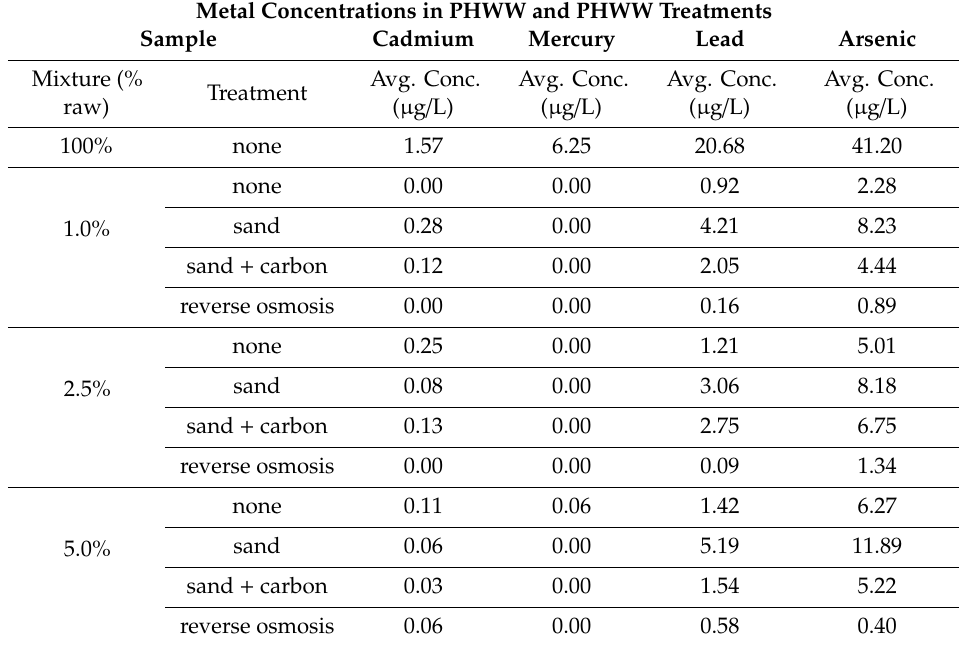
Table 2. Metal concentrations in the raw PHWW and treated PHWW. Concentrations are shown in µ g / L. Metal Concentrations in PHWW and PHWW Treatments